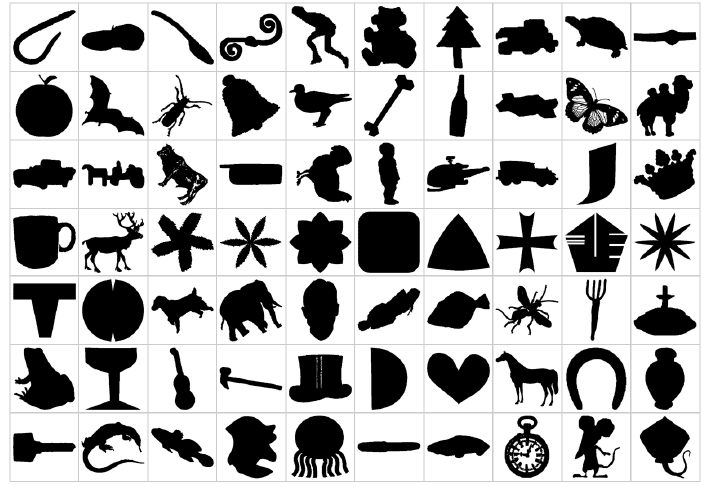
Figure 10. MPEG-7 CE-Shape-1 database, one sample image from each of 70 classes.